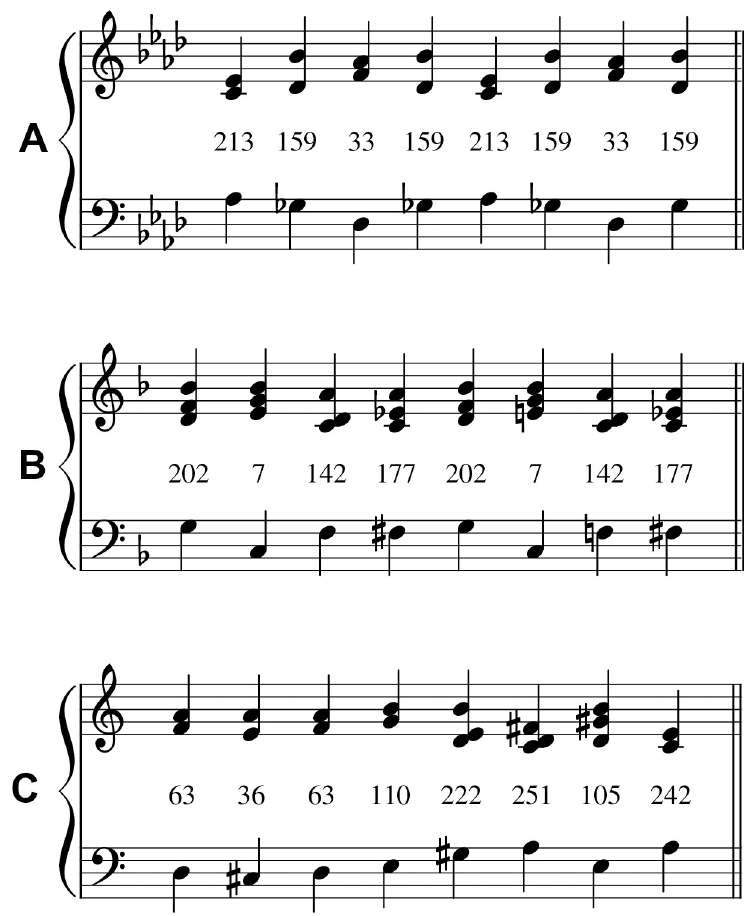
Fig 3. Sample chord sequences analyzed in Experiment 2. A) represents the popular music corpus (‘Night Moves’, by Bob Seger), B) represents the jazz corpus (‘Thanks for the Memory’, by Leo Robin), and C) represents the Bach chorale harmonization corpus (‘Mit Fried und Freud ich fahr dahin’, by J. S. Bach). Each chord is labeled by its integer encoding within the chord alphabet for the respective corpus. Each chord sequence corresponds to the first eight chords of the first composition in the downsampled corpus. Each chord is defined by a combination of a bass pitch class (lower stave) and a collection of non-bass pitch classes (upper stave). For visualization purposes, bass pitch classes are assigned to the octave below middle C, and non-bass pitch classes to the octave above middle